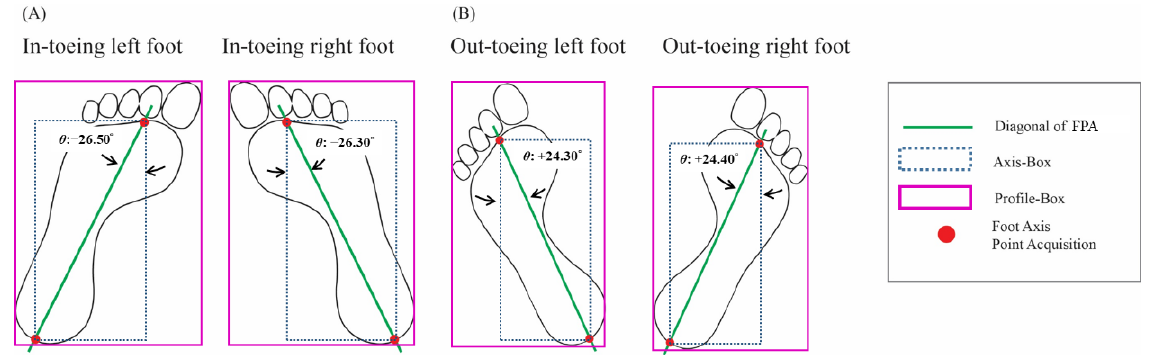
Figure 10. Different foot positions of in-toeing and out-toeing will acquire other foot axis points. ( A ) the method for diagonal FPA acquisition of in-toeing. ( B ) the method for diagonal FPA acquisition of out-toeing.